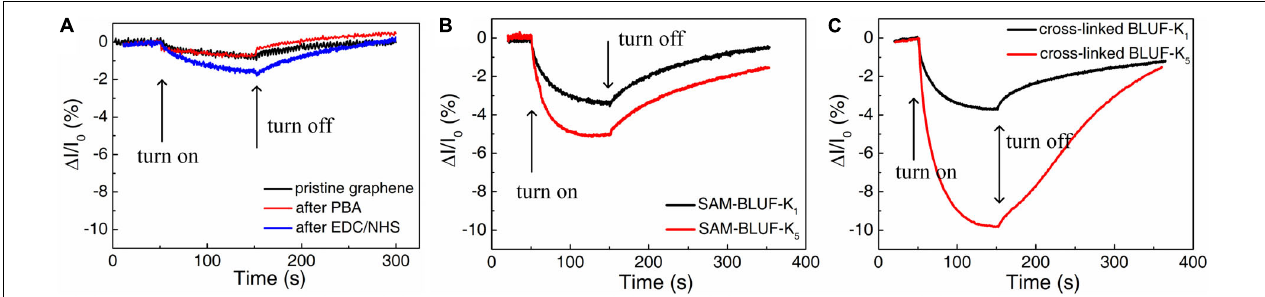
FIGURE 6 | The real-time photocurrent response for the devices with different functionalization. (A) Before the modification of protein. (B) The devices functionalized with self-assembled monolayer of BLUF-K 1 (black) and BLUF-K 5 (red), respectively. (C) The devices functionalized with cross-linked BLUF-K 1 (black) and BLUF-K 5 (red), respectively. Responses were shown to 450 nm light under 350 W/m 2 . Bias voltage is 10 mV.